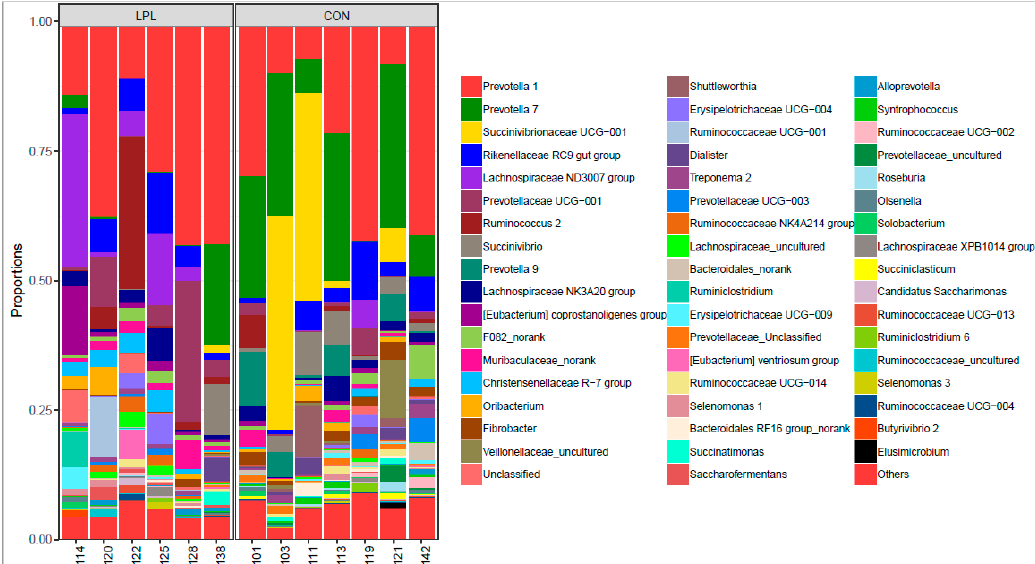
Figure 2. Distribution of the most dominant genera in the rumen of fattening lambs fed a diet supplemented without (CON) or with (LPL) 0.05% lysophospholipid (those with a relative abundance of less than 1% were combined as other).